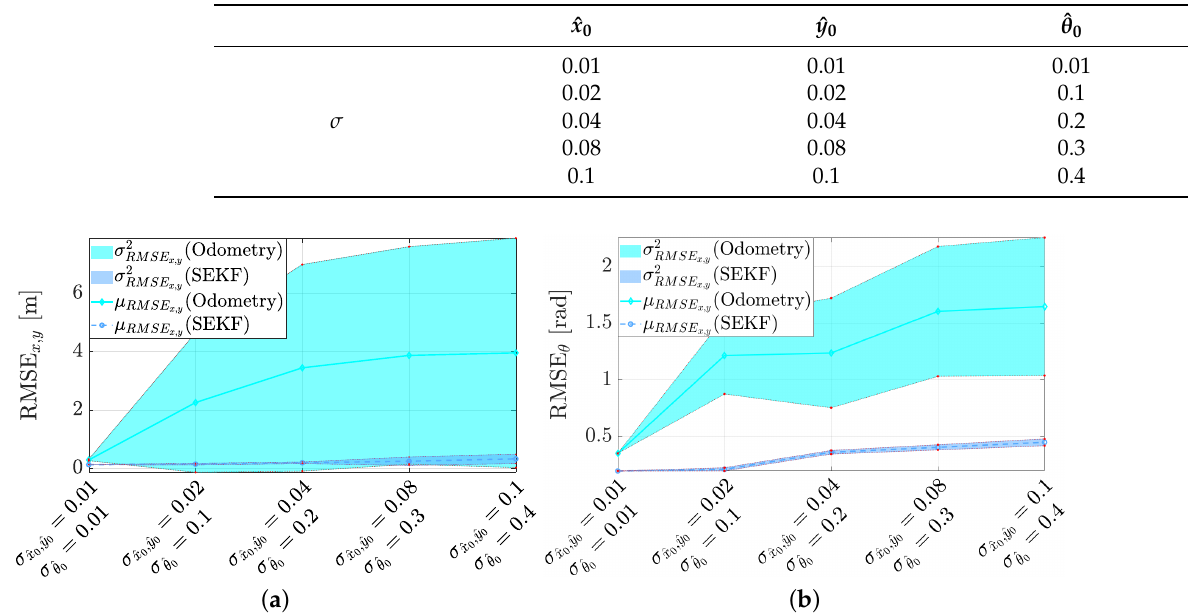
Figure 14. Localisation estimation accuracy in presence of different uncertainties about the true initial conditions for ( a ) the position and ( b ) the orientation.